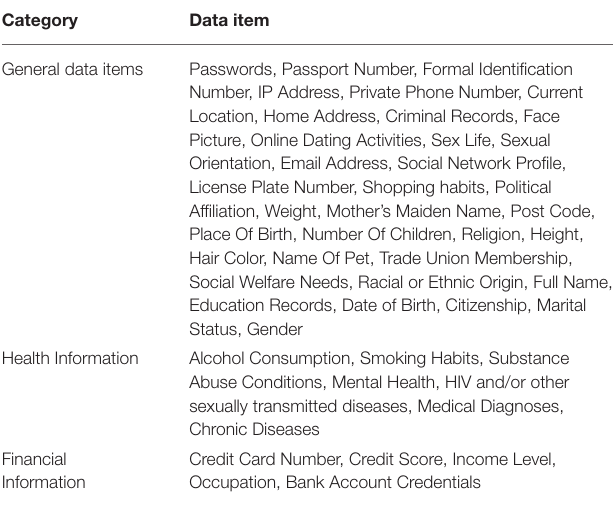
TABLE 1 | The full list of data items used in the study.